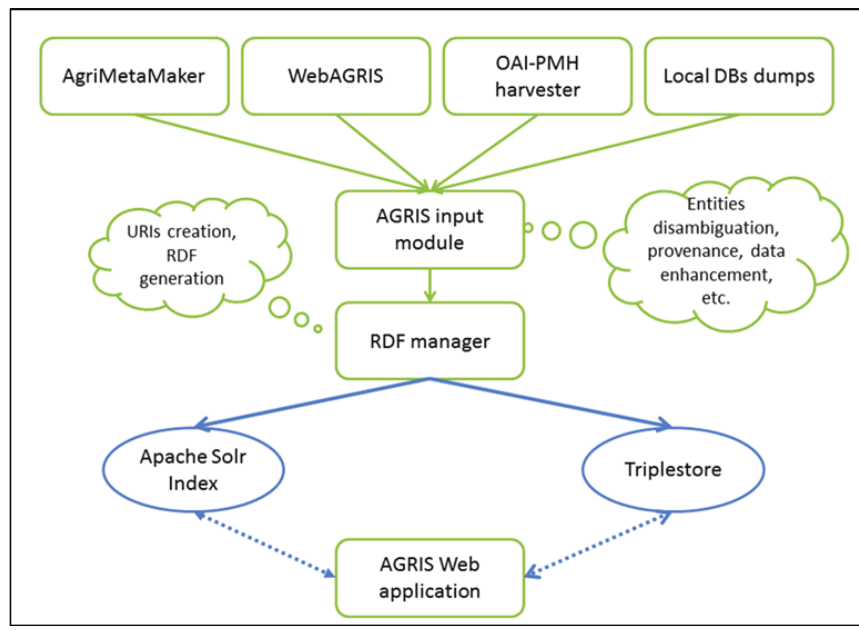
Figure 4. AGRIS dataflow and processing summarising different AGRIS data ingestion workflows and processing 9